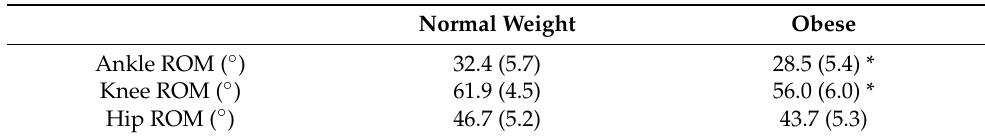
Table 3. Comparison between dynamic ROM of normal weight and obese individuals. Values are expressed as mean (SD).